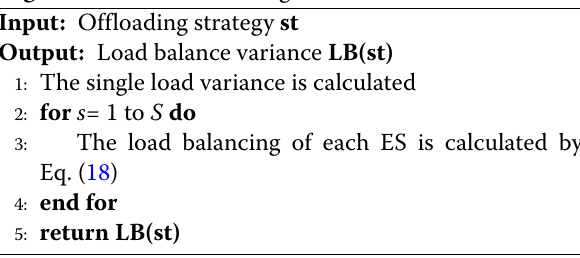
Algorithm 4 Load balancing calculation